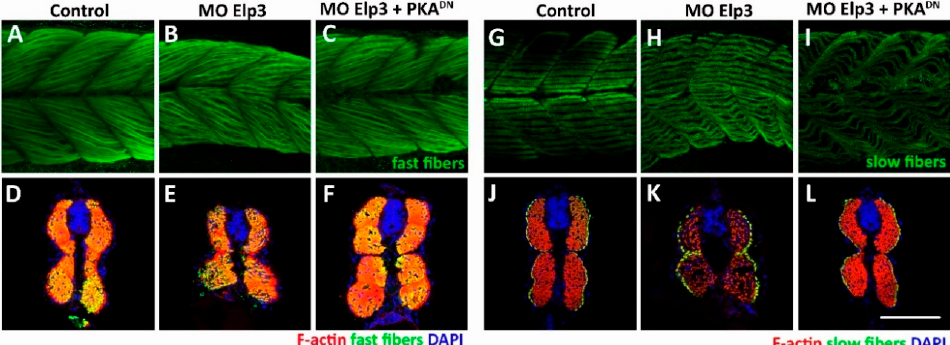
Figure 3. Abnormalmusclefiber morphologyinmorphants. Muscle fibersofcontrol( A , D , G , J ),morphants Figure 3. Abnormal muscle fiber morphology in morphants. Muscle fibers of control ( A , D , G and J ), morphants ( B , E , H and K ) and MO + PKADN mRNA injected ( C , F , I and L ) were analyzed. Upper ( B , E , H , K ) and MO + PKADN mRNA injected ( C , F , I , L ) were analyzed. Upper panels show fast fibers (F59) panels show fast fibers (F59) and lower show slow fibers (S58). F-actin was stained with TRICT- and lower show slow fibers (S58). F-actin was stained with TRICT-phalloidin. Scale bar 50 µ m. Images phalloidin. Scale bar 50 µm. Images representative of 4 independent experiments. representative of 4 independent experiments.